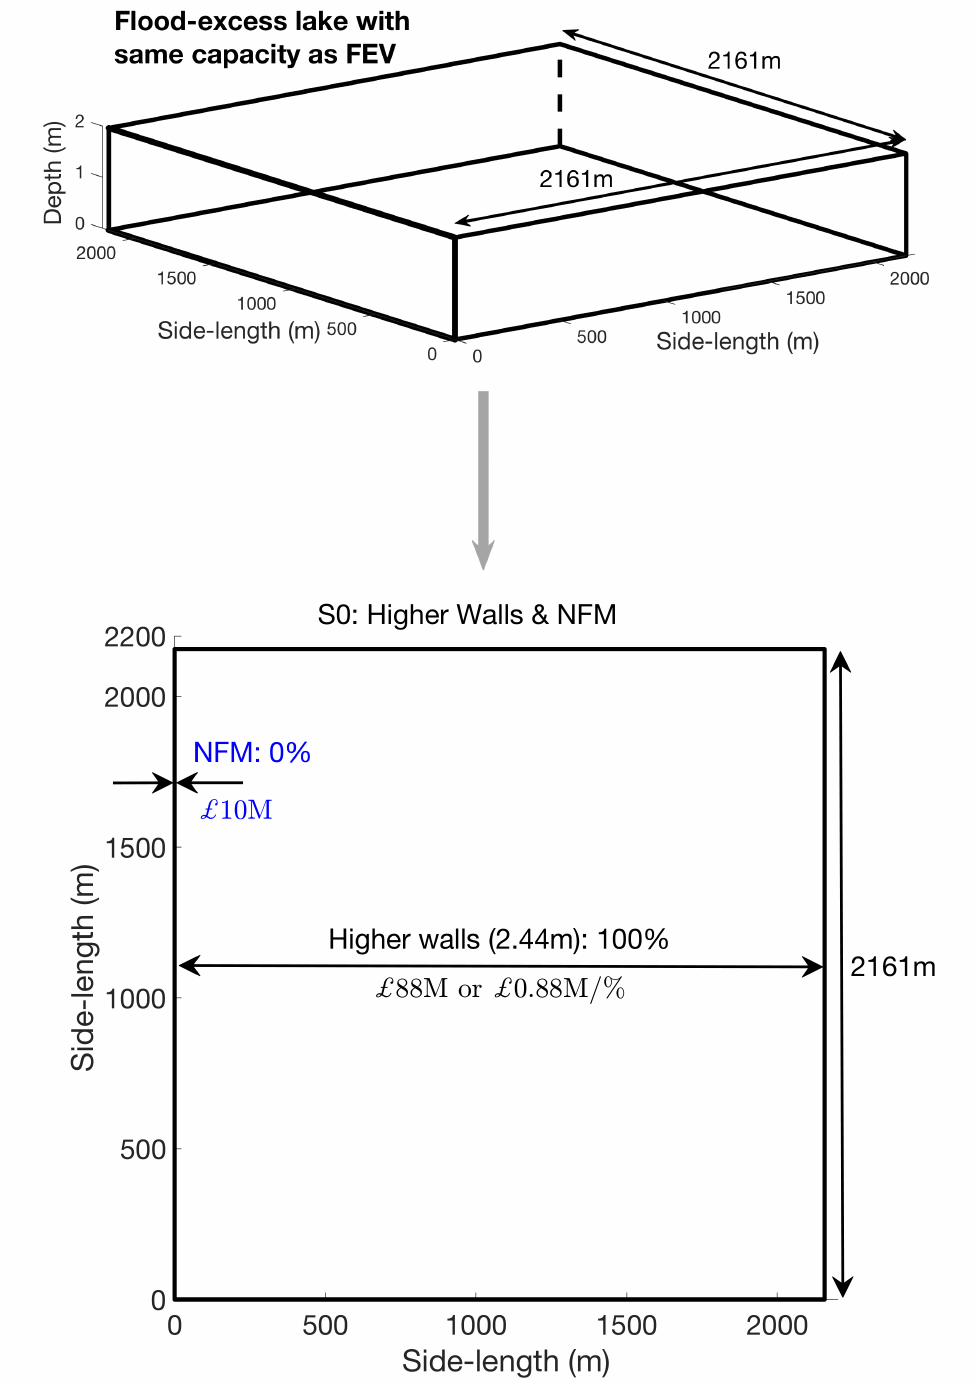
Figure 9. Top: FEV expressed as a square 2 m-deep lake of side-length 2161 m. Bottom: the FEV lake, shallow relative to its side length, viewed from the top. Basic scenario S0 is depicted with higher flood-defence walls and National Flood Management (NFM) giving respectively 100% and 0% protection (see Appendix B) against the desired 1:200-year return-period flood event. Indicated in the square lake are the relative size of each flood-mitigation measure, expressed both as lake area and the length of double-ended arrows, and its costs in UK pounds sterling. Split and total costs are indicated in absolute terms and per percentage of the total flood mitigation gained. Total costs (excluding NFM), here equalling the protection offered by using only higher flood-defence walls, are indicated underneath the double-ended arrow spanning the width of the entire flood